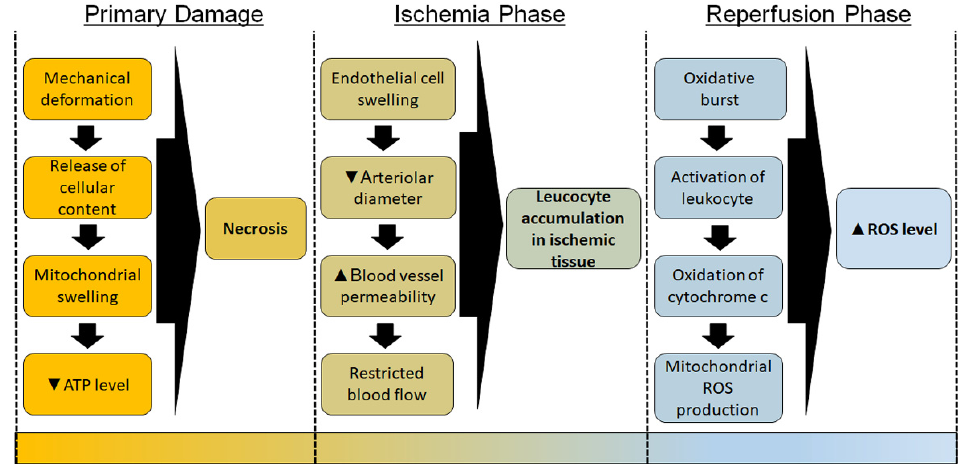
Figure 1. Timeline of the pathology in the development of chronic pressure ulcer (PU). The scheme displays the chrono- logical order of pathological events that occur during the primary damage of the skin, the ischemia phase, and the reper- fusion phase that lead to the development of PU. ▲ —Increase; ▼ —Decrease.